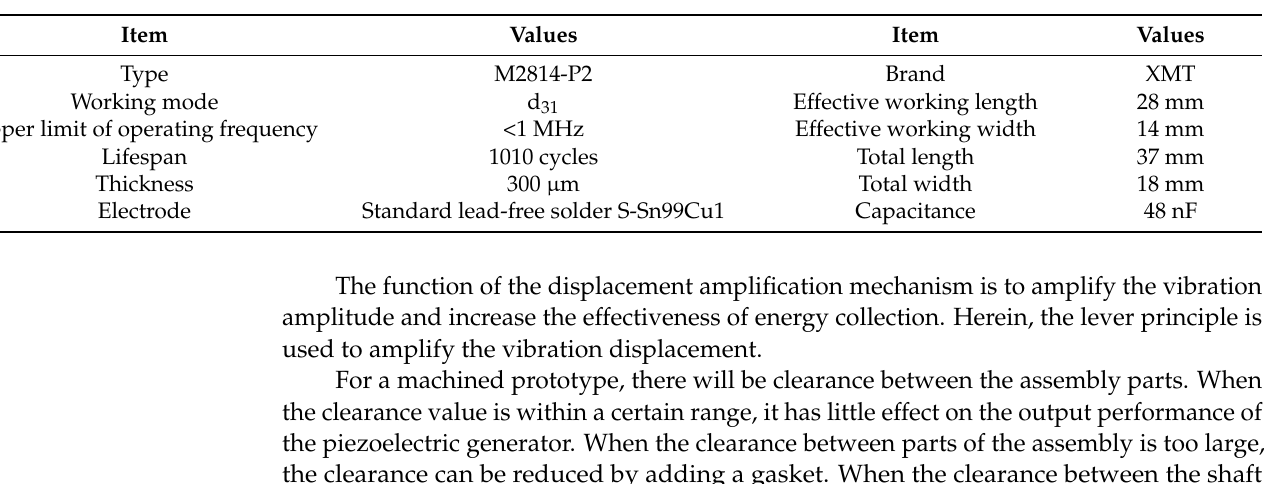
Figure 1. Structure of the micro-power piezoelectric generator. ( a ) 3D model; ( b ) prototype. (1) Telescoping rod; (2) cover; (3) body case; (4) displacement amplifying mechanism; (5) flexure strip; (6) MFC piezoelectric films; (7) position-limit mechanism; (8) fixed pin. Table 1. Performance parameters of MFC piezoelectric film.